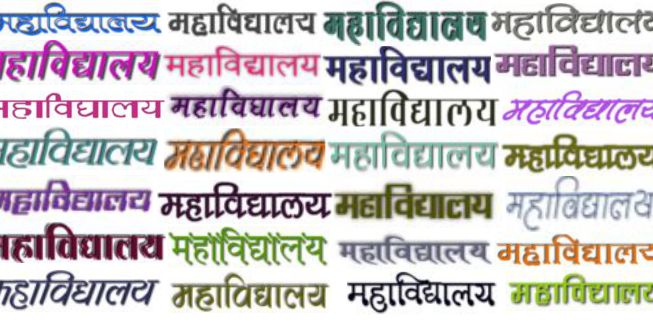
Figure 5. Examples of non-Unicode Hindi fonts used for synthetic data